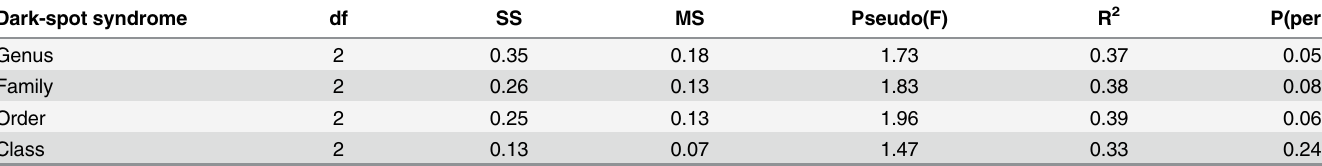
Permutational multivariate analyses of variance (PERMANOVA) comparing bacterial communities among healthy, exposed, and diseased-coral colonies (~16 cm 2 ) tested in laboratory-based dark spot-transmission experiments on Siderastrea siderea . Differences in bacterial communities were examined at each of four taxonomic levels. df = degrees of freedom; SS = sum of squares, MS = mean sum of squares; Pseudo(F) = permuted F-value; P(perm) = permuted p-value.